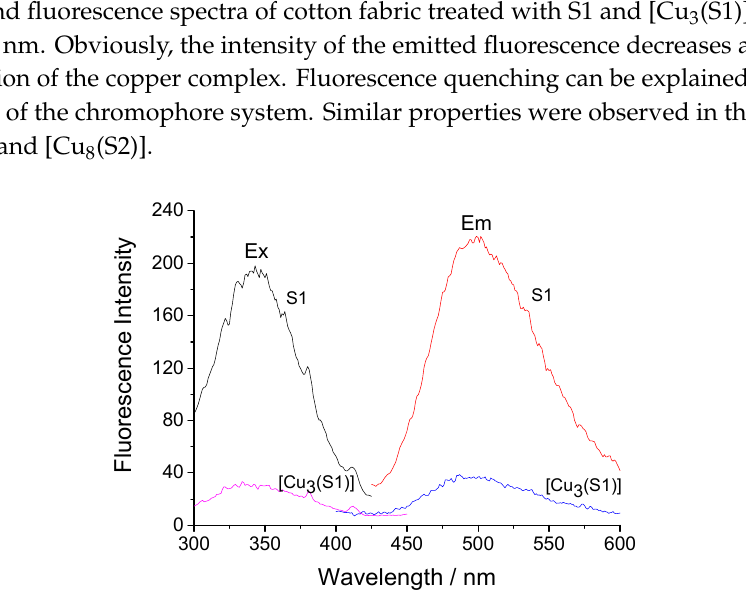
Figure 4. Excitation (Ex) and fluorescence (Em) spectra of cotton fabric treated with S1 and its [Cu 3 (S1)] complex.